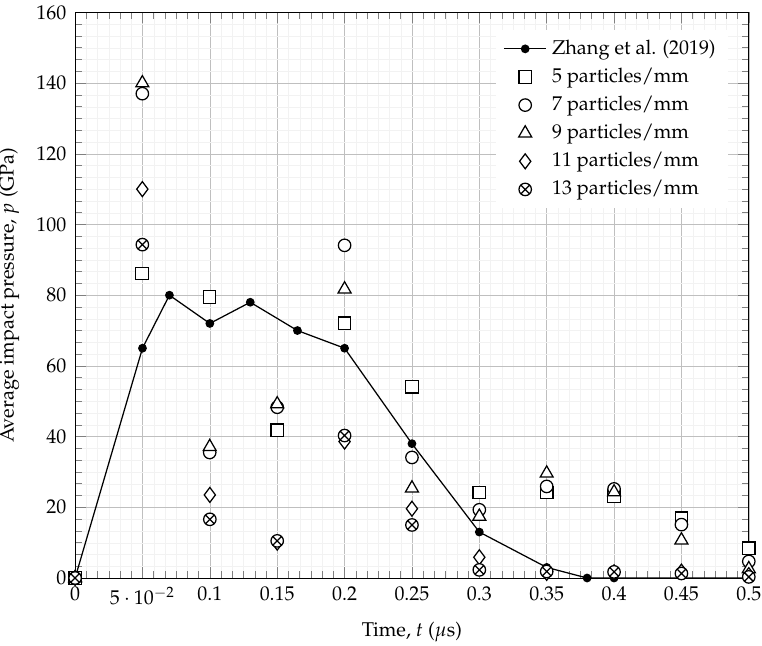
Figure 8. Average impact pressure p for varying SPH density and comparison with observations by Zhang et al.